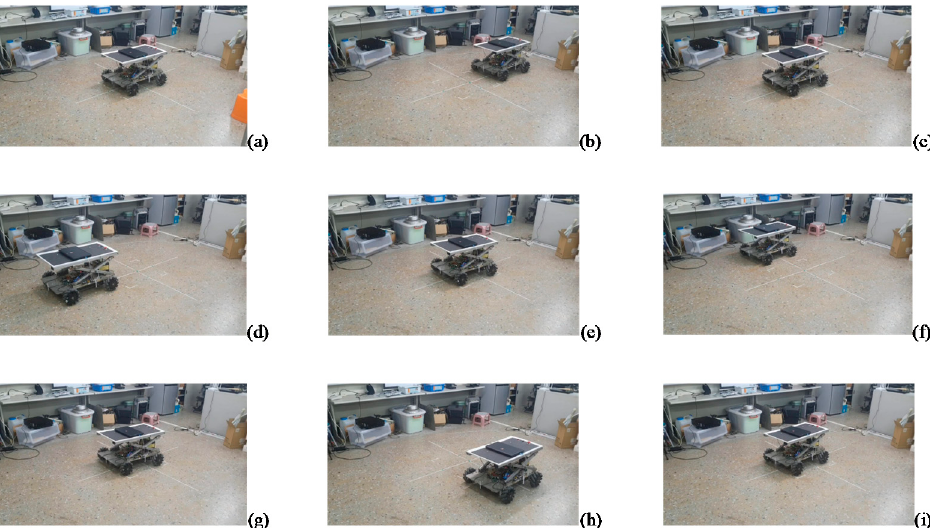
Figure 22. The captured pictures of the robot’s cross-walking motion with RLS estimation and compensation. ( a ) Starting position, ( b ) forward, ( c ) back to the starting position, ( d ) backward, ( e ) back to the starting position, ( f ) left shift, ( g ) back to the starting position, ( h ) right shift, ( i ) back to the starting position.